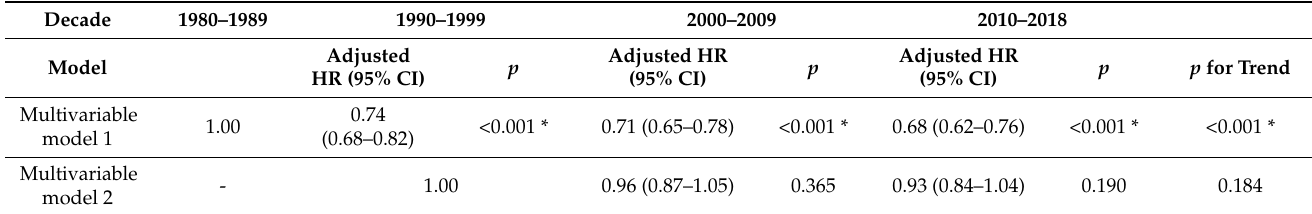
Table 2. Trends in the adjusted HR for